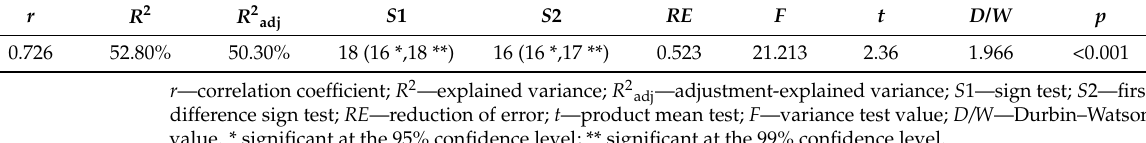
Figure 6. Correlation analysis between July NDVI and monthly mean temperature ( a ). Total precipitation ( b ) from the Meixian, Zhouzhi, Taibai and Foping stations during AD 1991–2013.